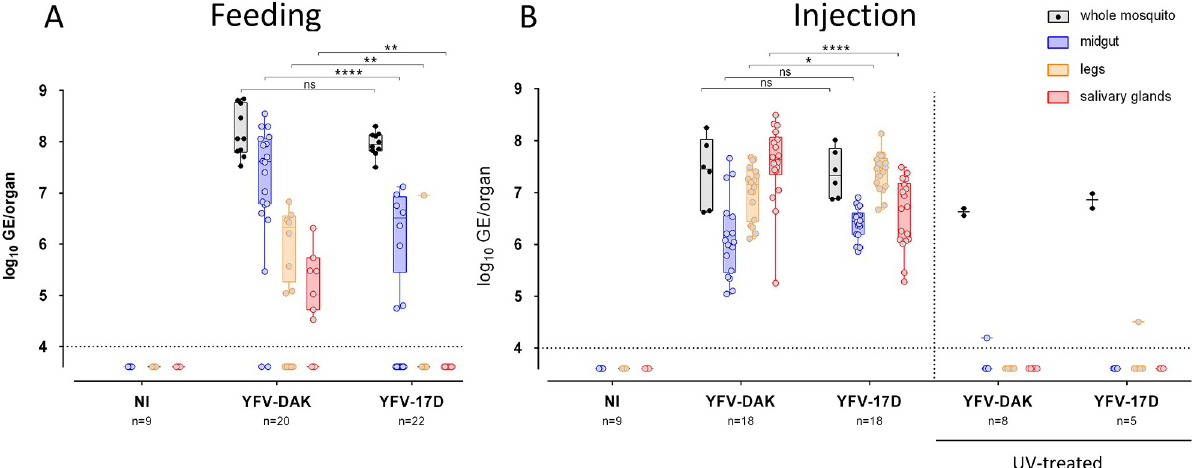
Fig 4. YFV-17D and YFV-DAK replicate in secondary organs when inoculated intra-thoracically. (A) Mosquitoes were orally infected via a blood meal containing 4.10 7 PFU/mL of YFV-DAK, YFV-17D or no virus. Alternatively (B), mosquitoes were inoculated intra-thoracically with 2.5x10 4 PFU of YFV-17D or YFV-DAK or with the same amount of UV-treated viruses. The relative amounts of organ-associated viral RNA were determined by RT-qPCR analysis 10 days after infection and are expressed as genome equivalents (GE) per organ. Several whole mosquitoes were also analyzed the day of the feeding or injection to ensure that a similar amount of viral particles of both viral strains were delivered in mosquitoes (black boxes). The number of organs (n) analyzed is indicated. The dashed lines indicate the limit of detection. Three independent experiments were performed with untreated viruses. Control experiments with UV-treated viruses were performed once. Statistical analyses were performed using a Mann-Whitney test ( � p < 0.05; �� p < 0.01; ��� p < 0.001; ���� p < 0.0001).